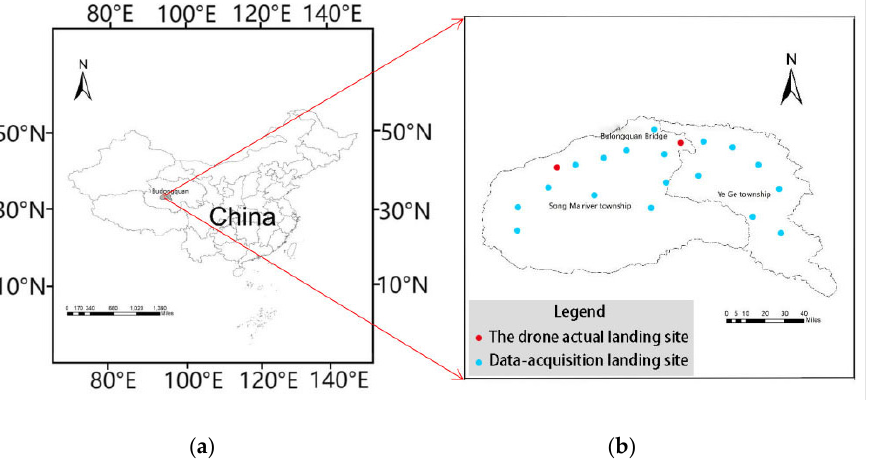
Figure 1. The research area in this work. ( a ) Geographical location of Budongquan; ( b ) distribution of UAV landing sites in July.